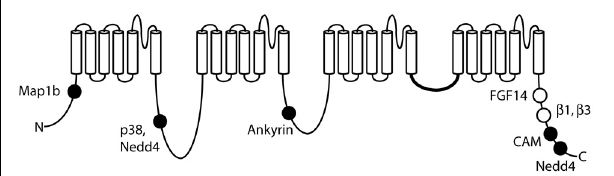
FIGURE 4 | Locations of protein interactions with Na v 1.6. Filled circles represent binding sites that have been localized to specific residues